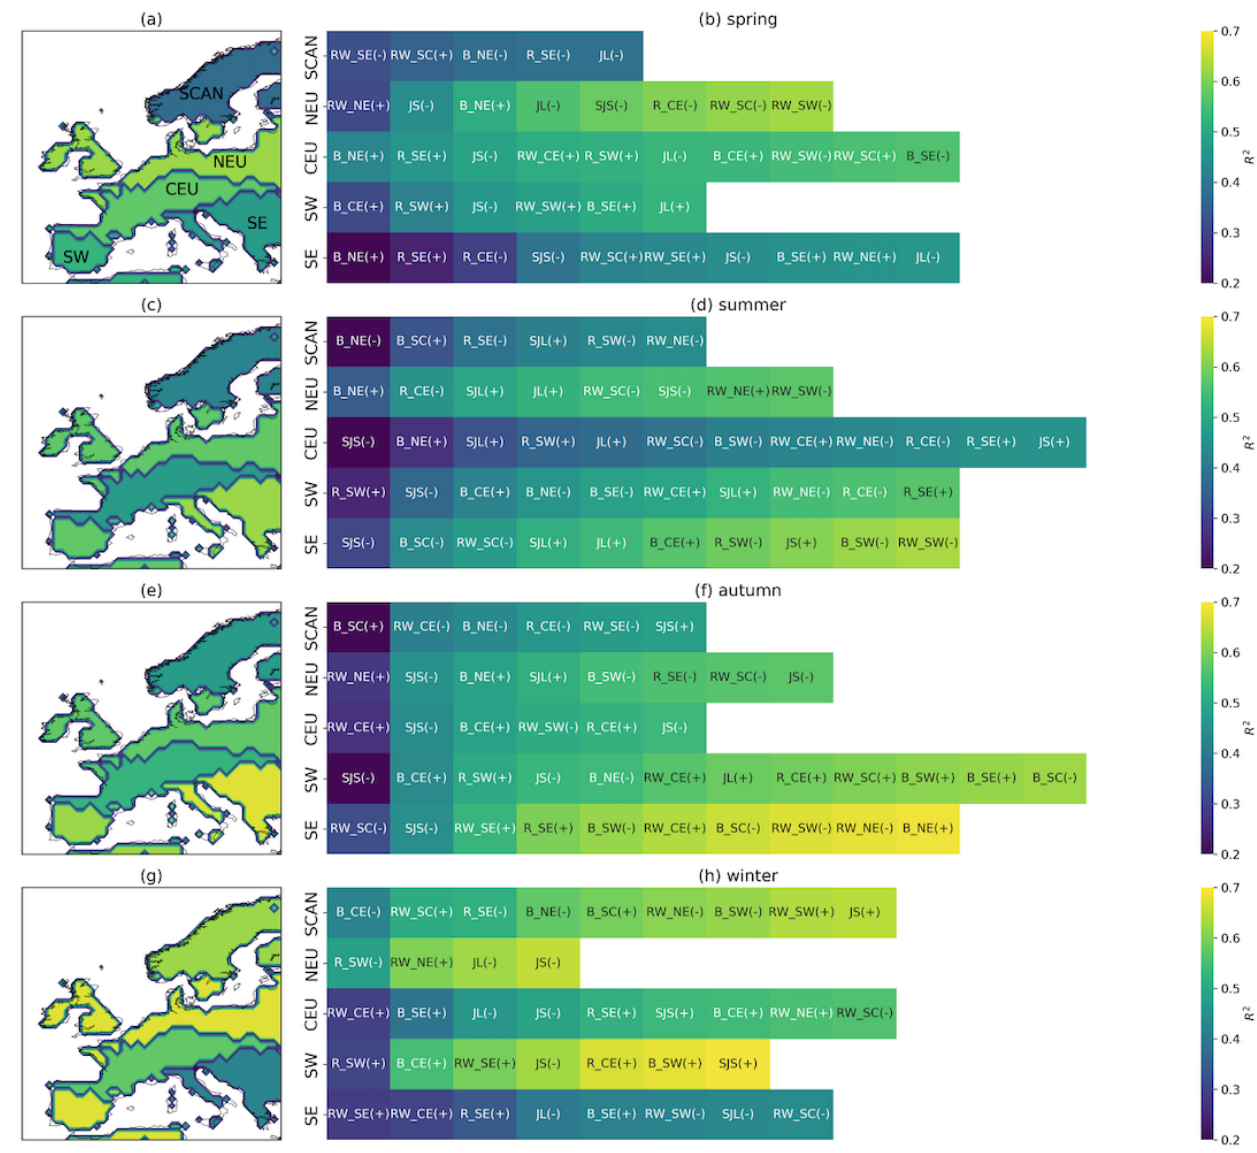
Figure 7. Model R 2 for stagnation occurring in (a) spring, (c) summer, (e) autumn and (g) winter. Predictors included in the stepwise linear regression for each region in (b) spring, (d) summer, (f) autumn and (h) winter, where the plus and minus signs for each predictor represent whether the coefficient in the MLR model is positive or negative, respectively. Colours in the right-hand panels show the R 2 of the model as each predictor is added in its formulation. The R 2 values are calculated for monthly data in